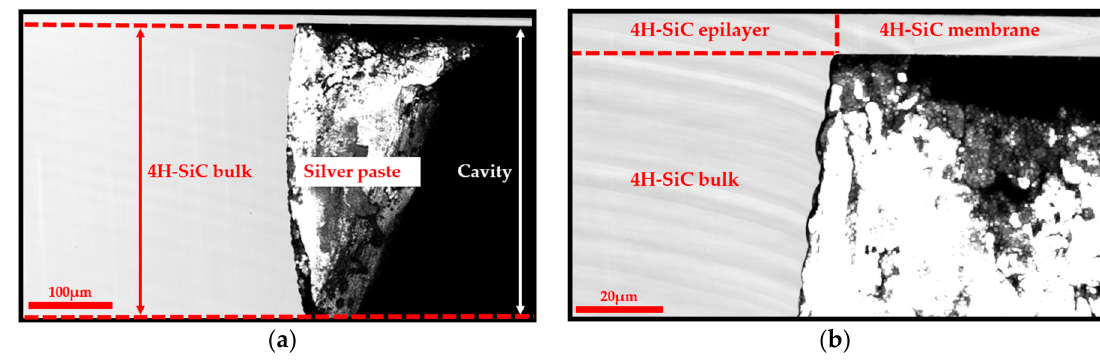
Figure 8. ( a ) LSM cross-section image of the etching profile; ( b ) LSM image of the membrane-undercut boundary.